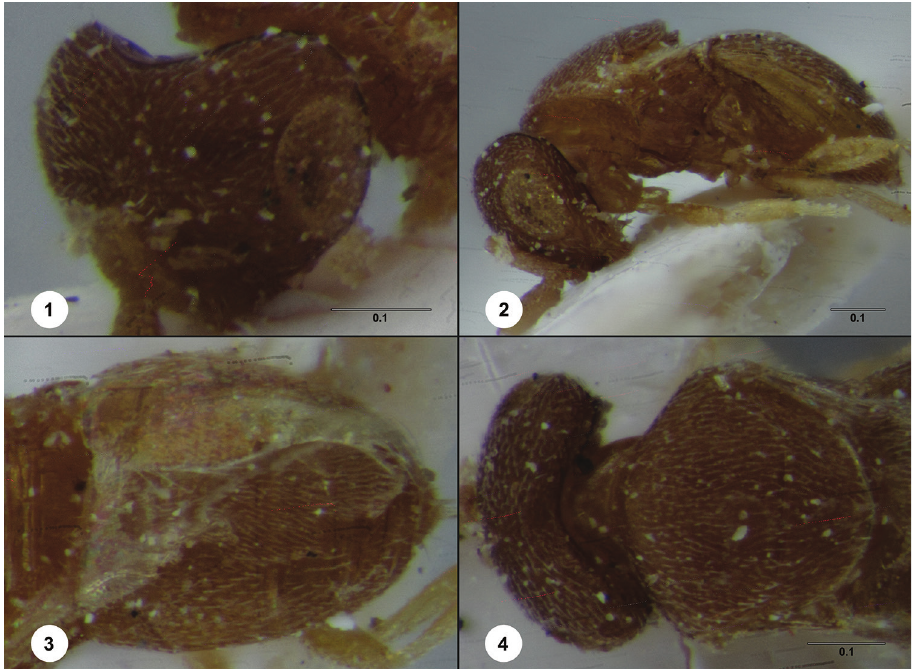
Figures 1–4. Dyscritobaeus microocellus , female holotype (IEBR 0164). 1 head, anterolateral view 2 head, mesosoma, metasoma, lateral view 3 metasoma, dorsal view 4 head and mesosoma, dorsal view. Scale bars in